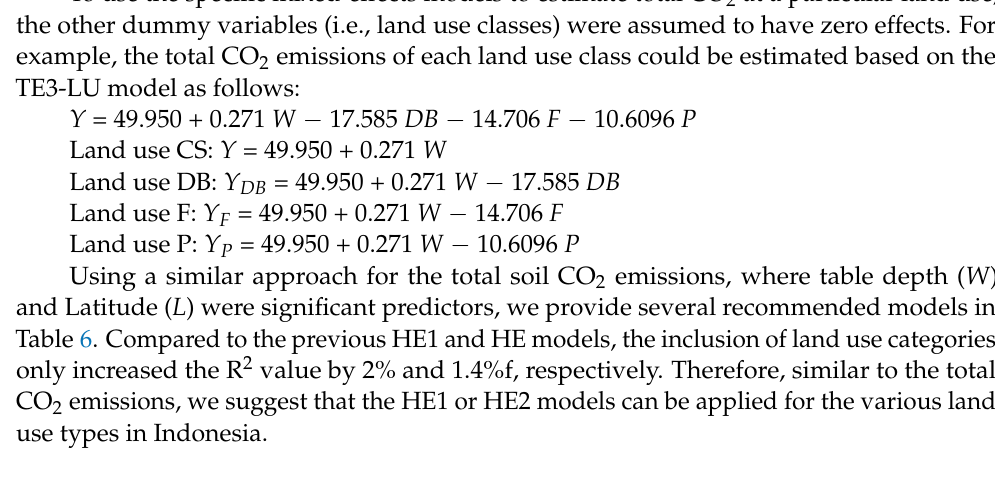
Table 5. Parameter estimates and goodness of fit statistics of the general mixed-effects models for estimating total CO 2 emissions for all land uses.